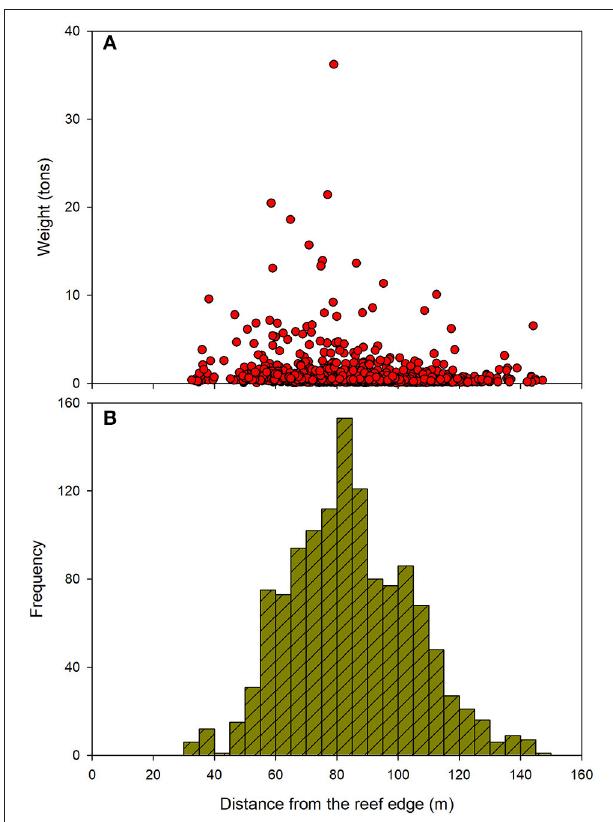
FIGURE 4 | The distribution of boulder weights (A) and the number of boulders (B) on the coast according to the distance from the reef